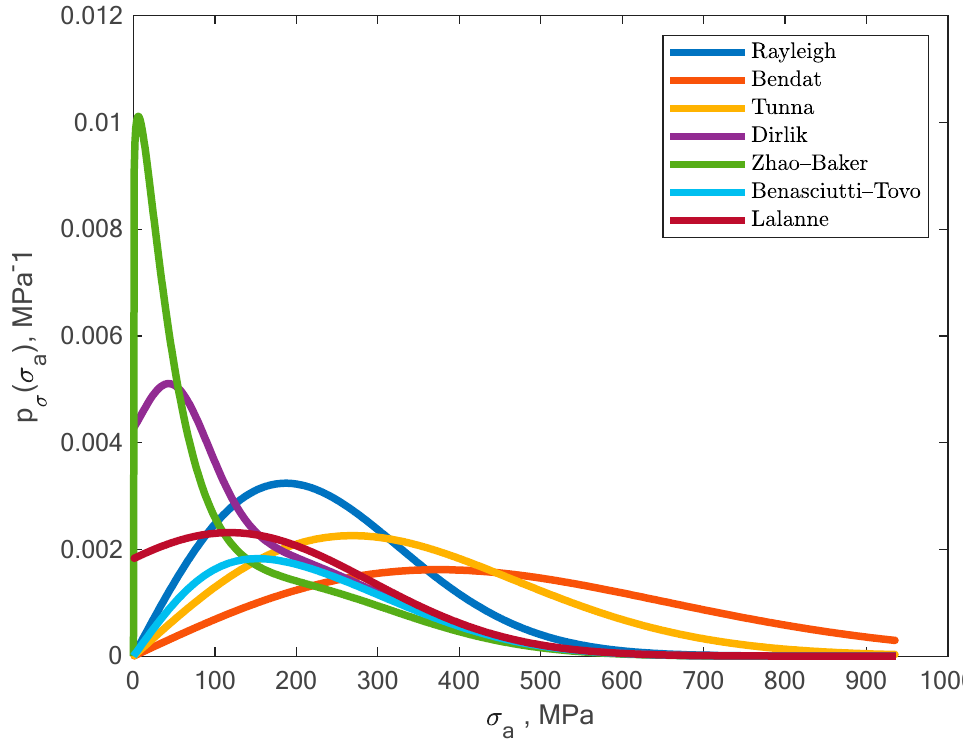
Figure 11. Obtained shapes of a wide range of probability distribution models after transformation due to elastoplastic deformations.